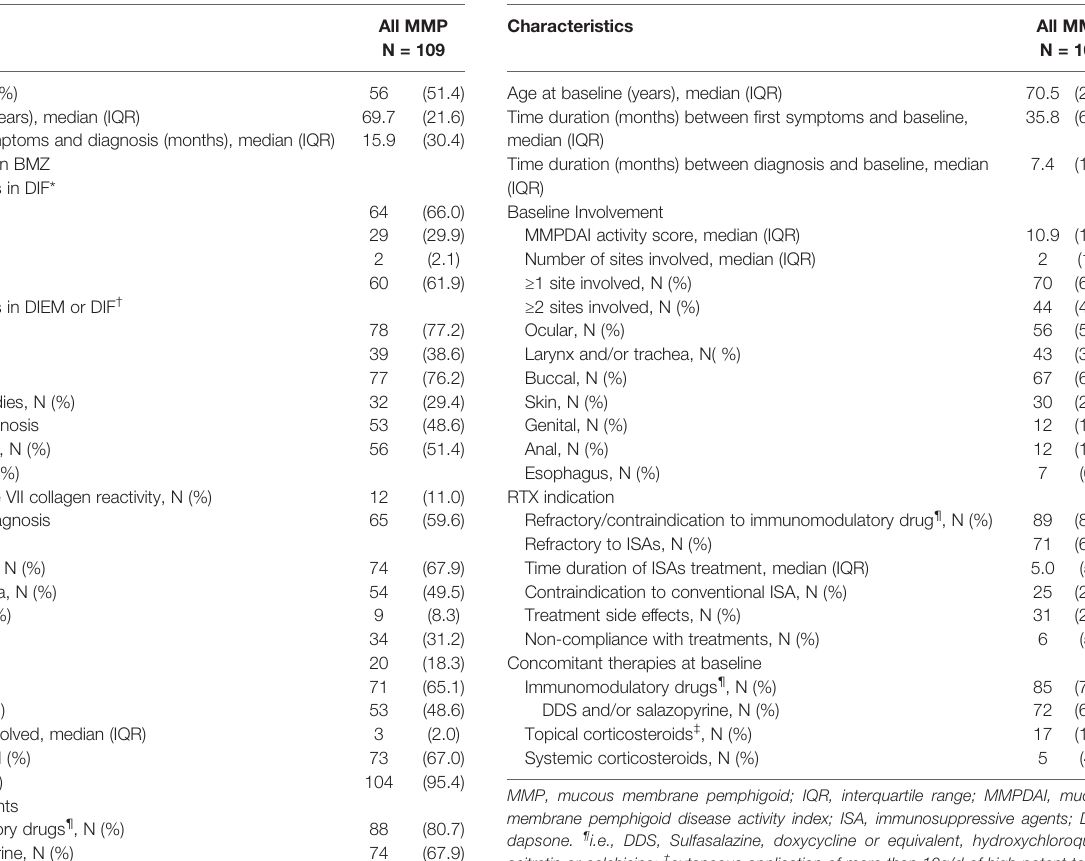
TABLE 1 | Mucous membrane pemphigoid characteristics at diagnosis. TABLE 2 | Patient characteristics at